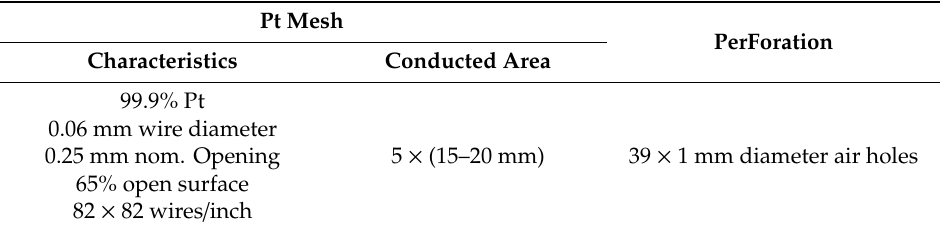
Table 1. Cell characteristics for through-plane measurements.